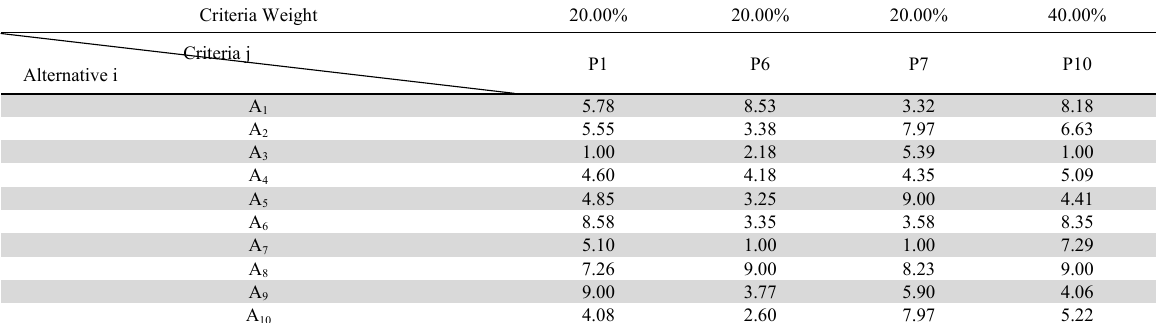
Normalization of X